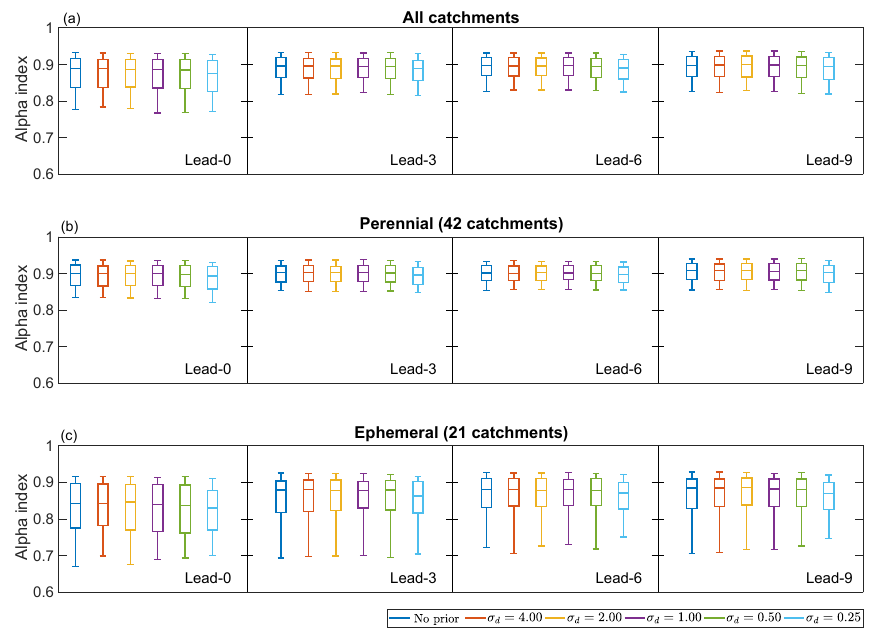
Figure 13. Reliability (alpha index) in 63 catchments by lead time for FoGSS forecasts with different strength priors on the d parameter (smaller values of σ d result in a stronger prior). For each lead time, reliability is summarized for all months with box and whisker plots. Boxes show the interquartile range with the median; whiskers give the 10th and 90th percentiles. (a) shows all catchments, (b) shows perennial catchments, and (c) shows ephemeral